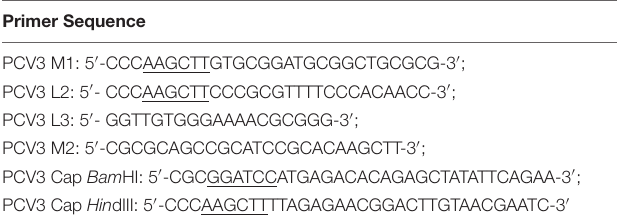
TABLE 1 | Primers used for the construction and identification of the recombinant virus. Primer